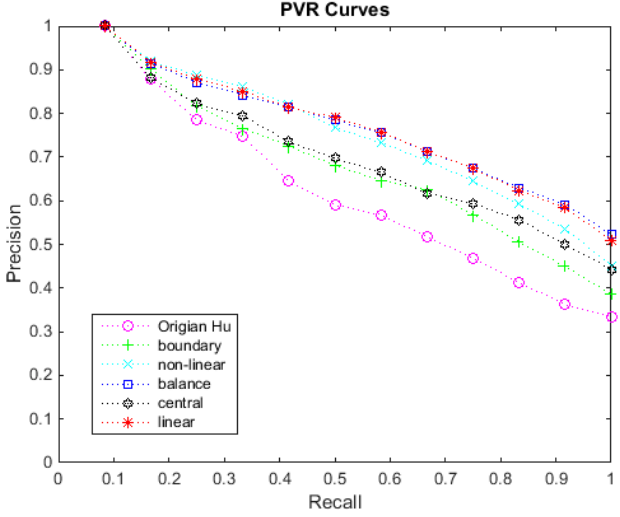
Figure 2. Average retrieval precision-recall curves on Kimia’s shape database.